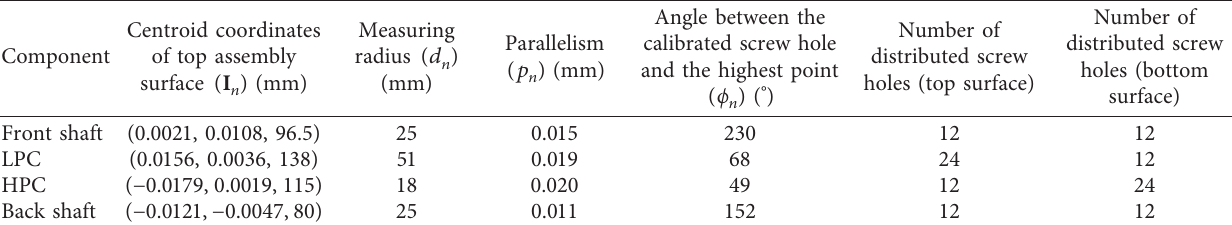
Table 7: The geometric parameters of the 4-stage rotor.